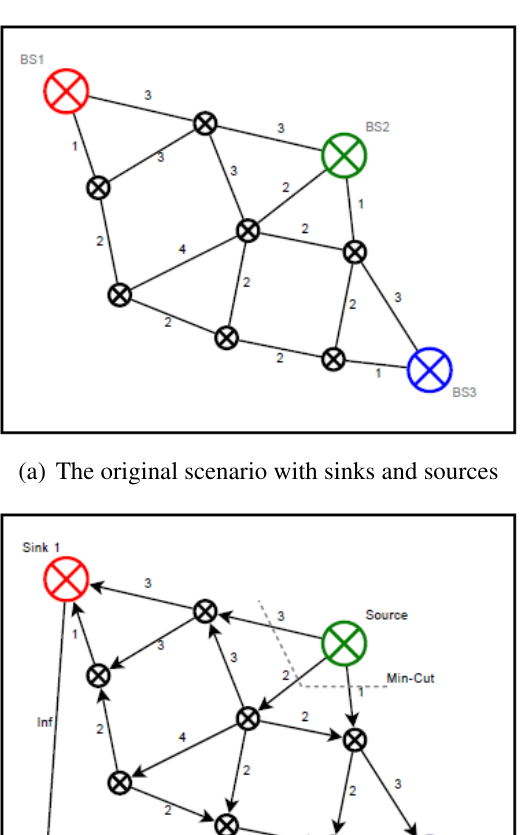
Figure 7. Super-sinks added in the